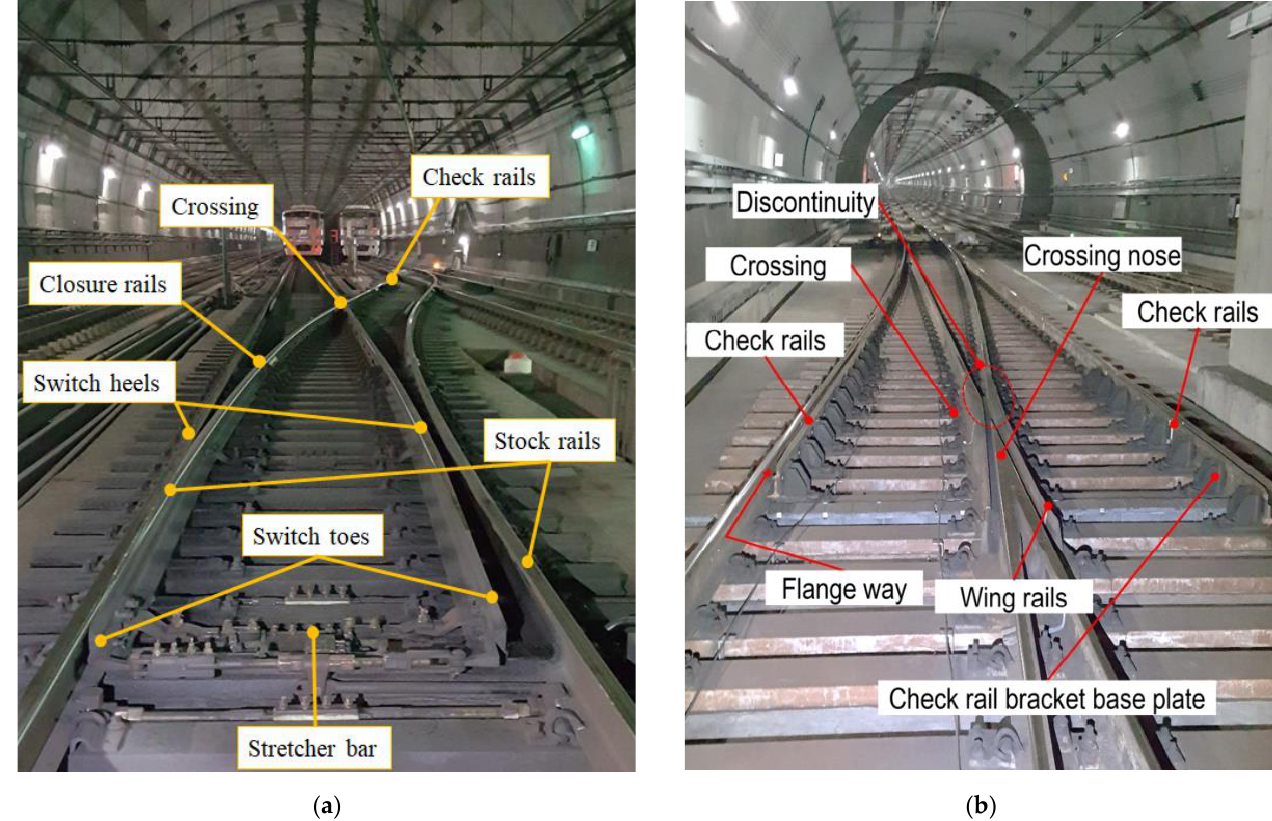
Figure 1. Various components of the turnout system: ( a ) front overview of turnout system and ( b ) components of the crossing panel.